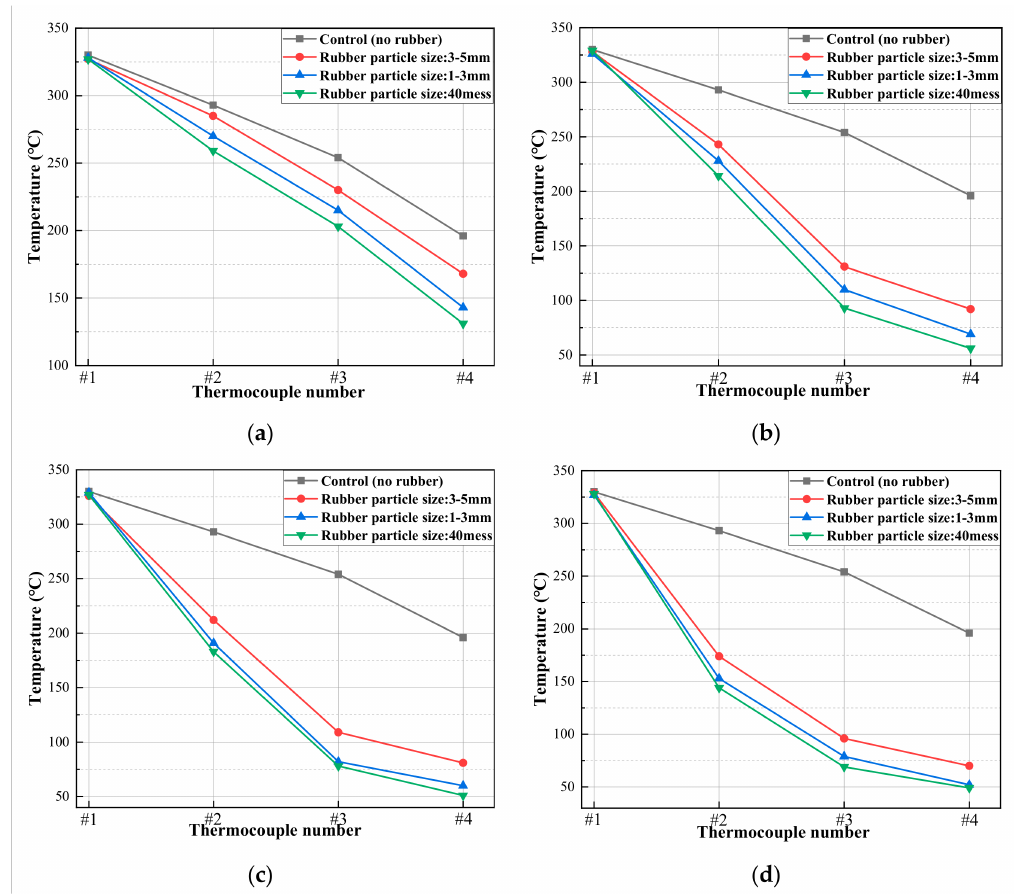
Figure 12. Thermocouple no-temperature curve of each specimen: ( a ) Rubber content, 15%; ( b ) rubber content, 30%; ( c ) rubber content, 40%; and ( d ) rubber content,